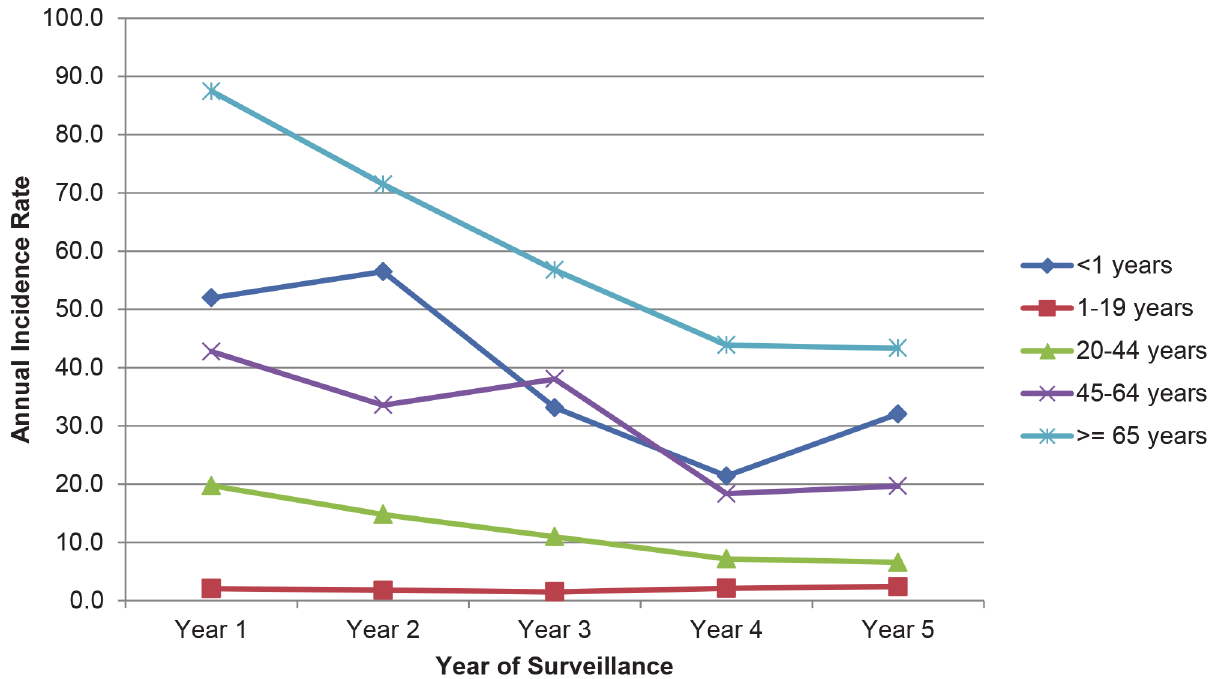
Fig 2. Annual candidemia incidence rates per 100,000 person-years, by year and age-group in the Metropolitan Baltimore area.